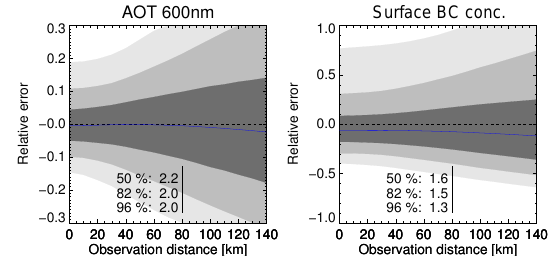
Figure 14. Relative spatial sampling error (monthly data) as a func- tion of distance of the observation to the grid point. Near the bottom horizontal axis, the ratios of (cid:49)q 25 ,(cid:49)q 82 and (cid:49)q 96 at a distance of 80 and 0km are given. Results from WRF-Chem MADE over W. Europe. Further explanation in Sect.